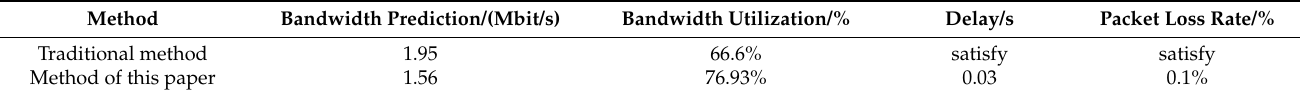
Table 5. Comparison of the predicted value of communication service bandwidth in intelligent distribution room. Method Traditional